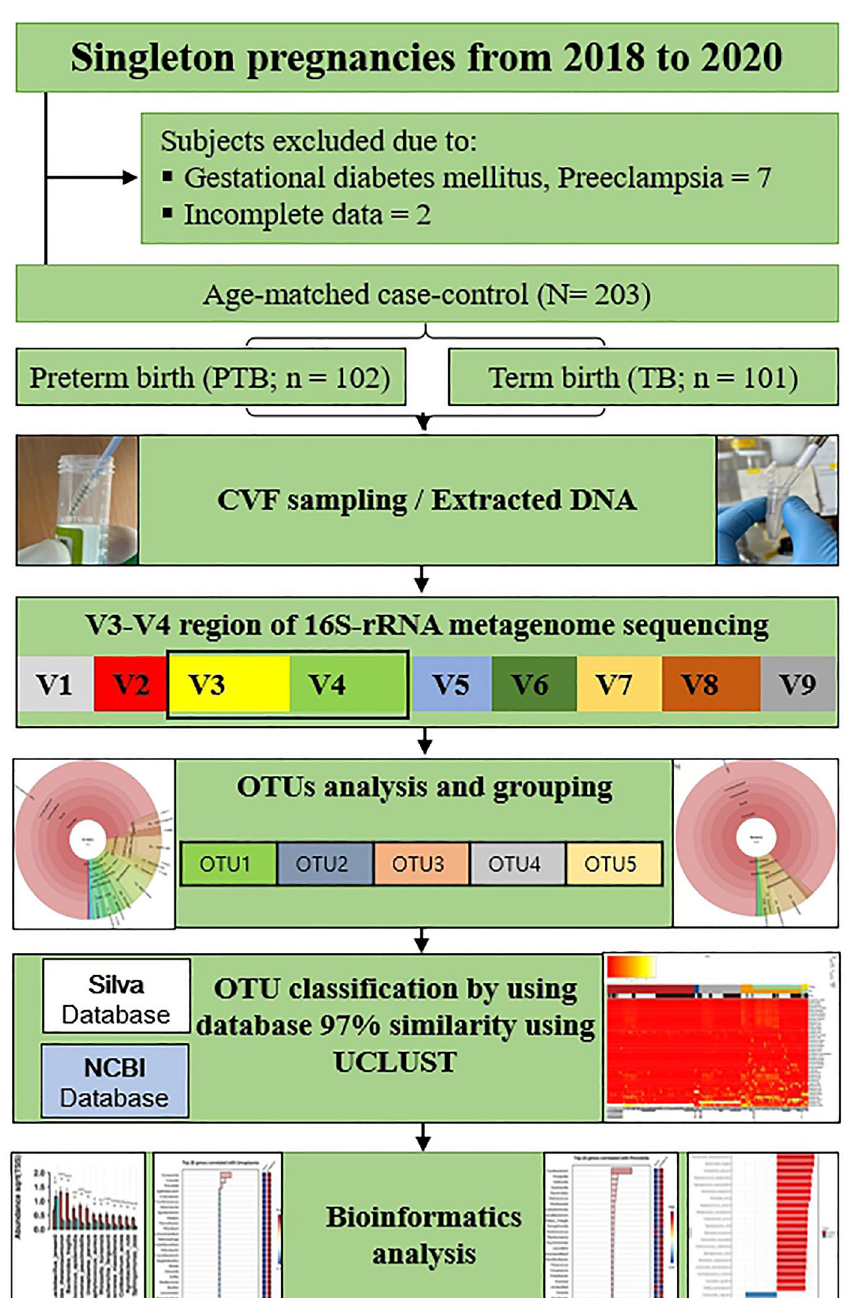
Figure 1. Flowchart of the study. CVF cervicovaginal fluid, rRNA ribosomal ribonucleic acid, OTUs operational taxonomic